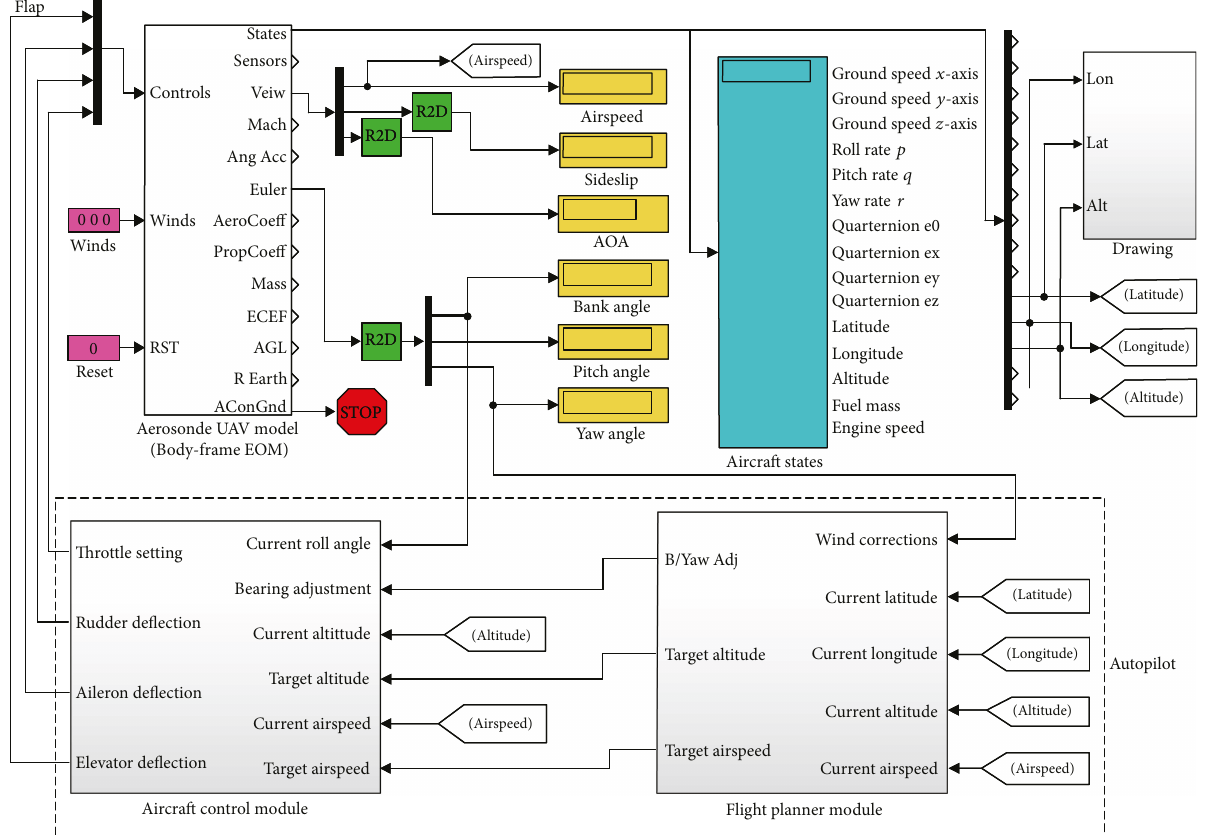
Figure 7: Closed loop simulation platform of the hybrid electric Aerosonde